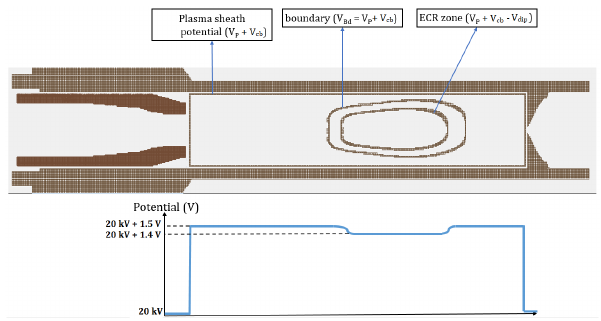
FIG. 5. The modified SP1 CB SIMON geometry with ECR plasma potential features (top figure). The assumed plasma potential distribution for the charge breeding simulations (bottom